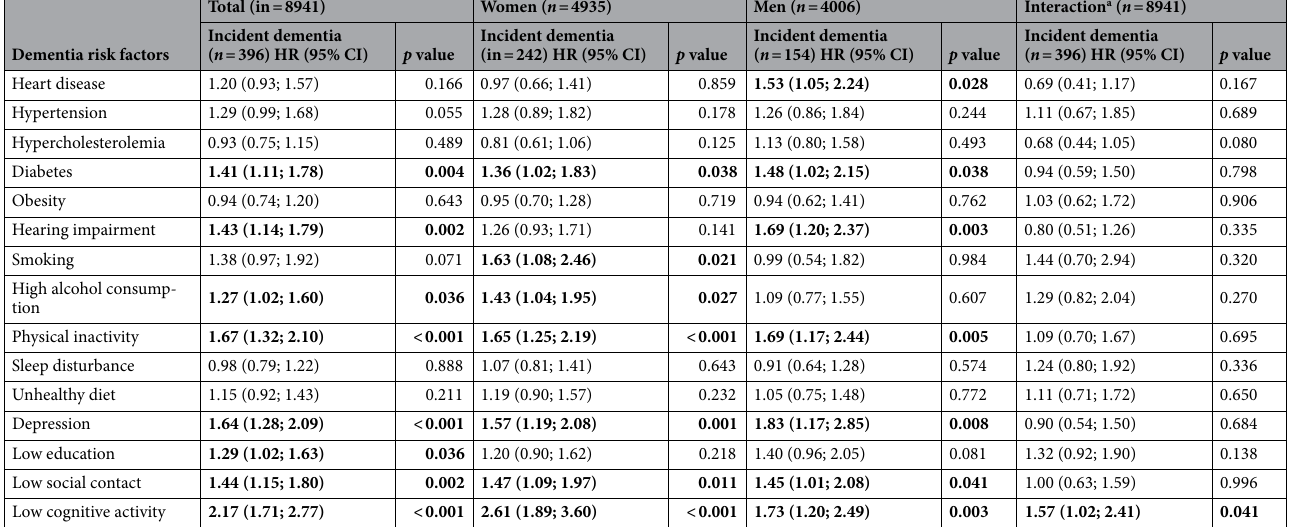
Table 2. The total and sex/gender-specific associations of dementia risk factors with incident dementia and the interactions of the dementia risk factors with sex on dementia risk. HR hazard ratio; CI confidence interval. Analyses are adjusted for age, sex/gender (total population), wealth and clustering at the household level. a The interaction of the risk factors with sex/gender on incident dementia with men as the reference category. Significant values are in